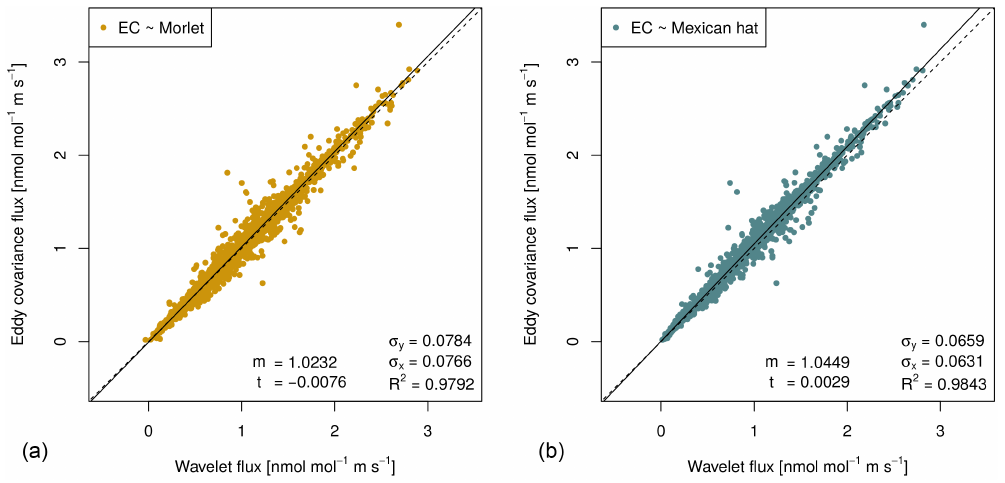
Figure 3. Scatterplot of Morlet (left) and Mexican hat wavelet methane flux (right) against eddy covariance for times with best steady-state conditions and well-developed turbulence. The dashed line follows the function f (x) = x and the solid one is the mean regression line.